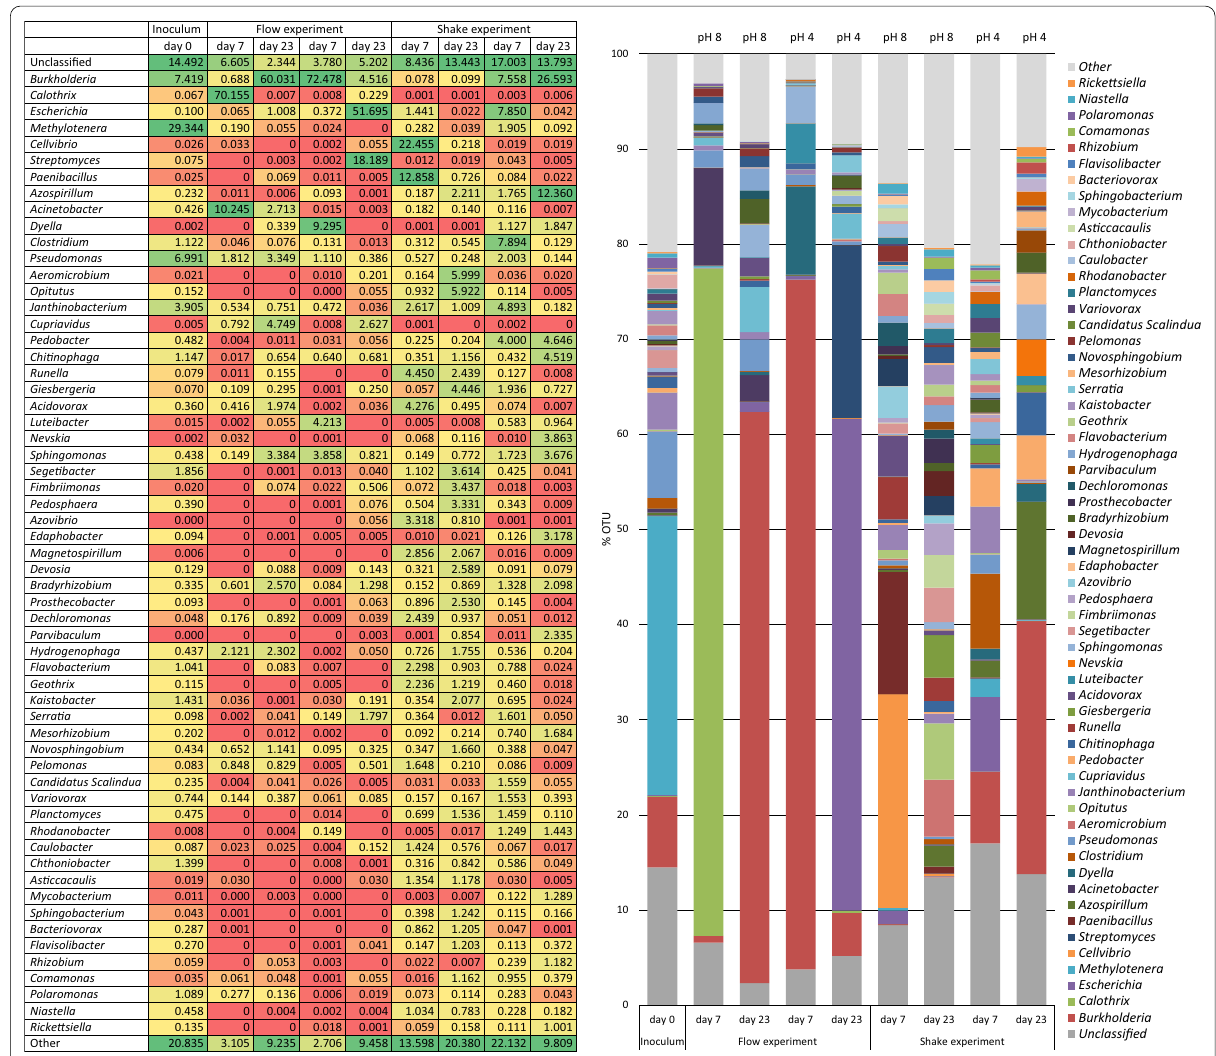
Fig. 2 Bacterial consortium composition (genus level) in garden soil samples as analysed by 16S rRNA amplicon sequencing after subjection to different environmental conditions (pH), different biofilm harvest time‑points, at 30 °C incubation temperature, and with cellulose as carbon source. Examined with flow and shake experiments and compared to the bacterial composition of the soil inoculum. a Heat map presenting the abundancy of dominating genera. b Consortium composition of the most dominating genera in inoculum sample as well as after enrichment. “Other” is the sum of all classified genera with individual abundancies below 1% in all samples. “Unclassified” includes sequences classified at higher taxonomic levels, but where no genus information could be